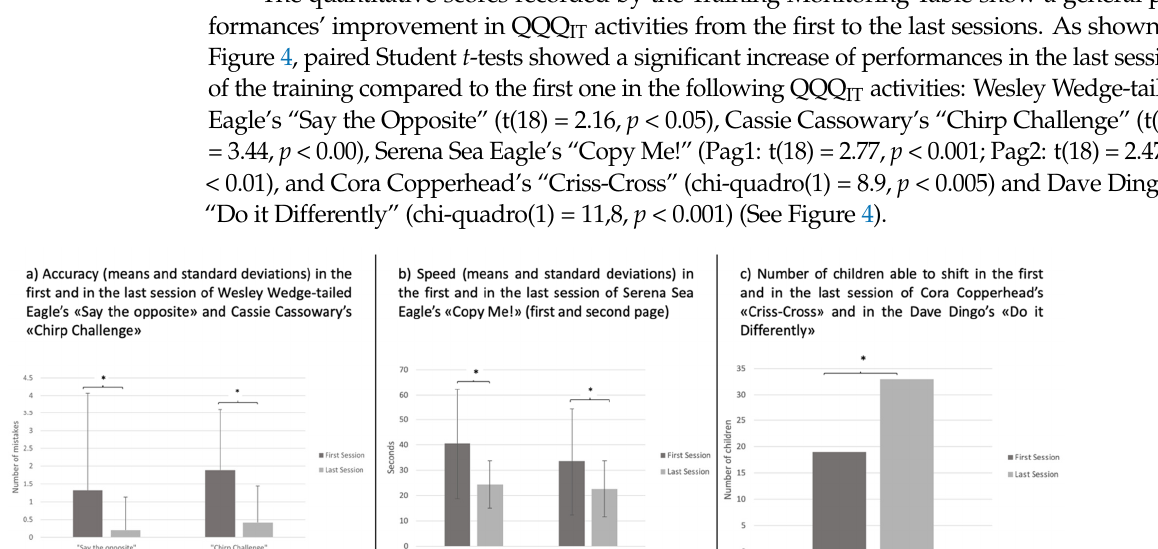
Table 2. Means (standard deviation) obtained in the EFs tests before intervention (control condi- tion, T0-T1) and after the intervention (experimental condition, T1-T2).